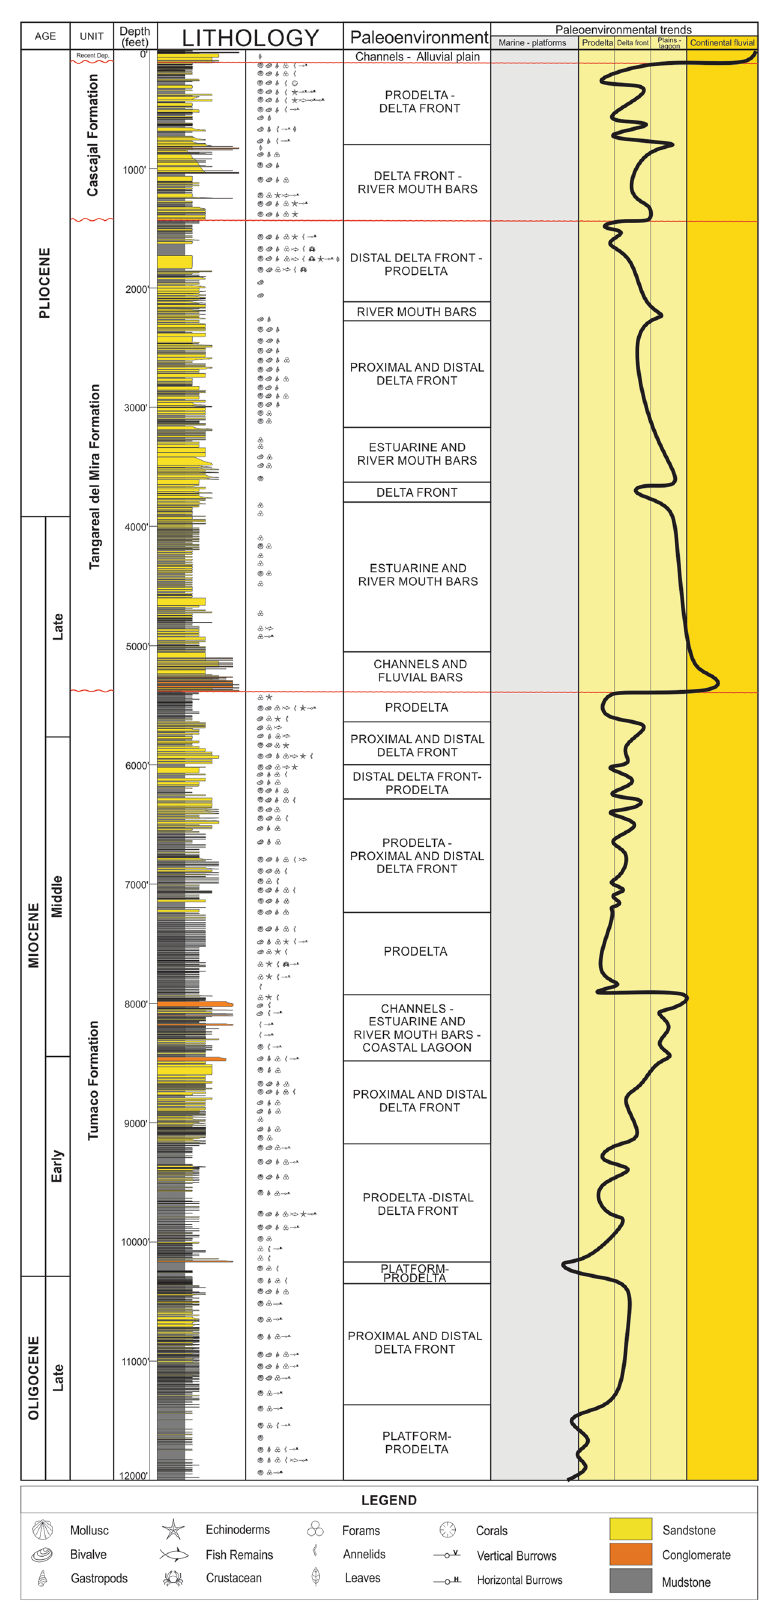
Fig. 6 Lithology, paleoenviron- ment and stratigraphic correla- tion for Tumaco-1-ST-S and Tumaco-1-ST-P wells (ANH- Antek S.A.